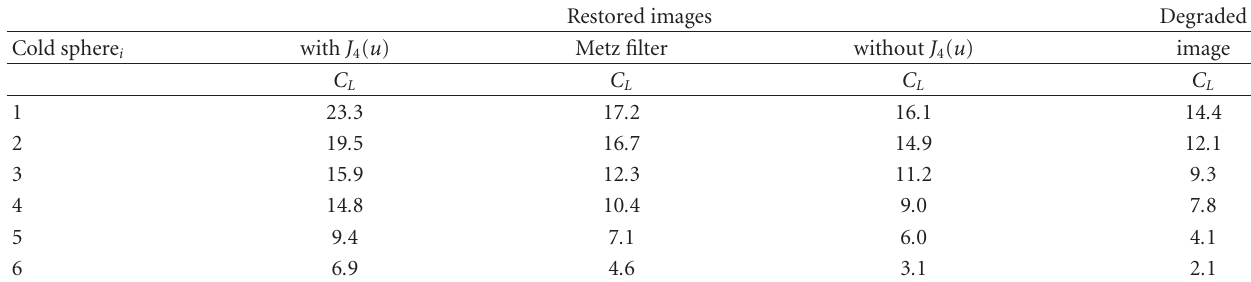
Table 3: The local contrast C L (expressed in %) with correct anatomic information obtained from, respectively, the restored image with and without J 4 ( u ), the Metz filter, and the degraded image that are the original phantom SPECT. Restored